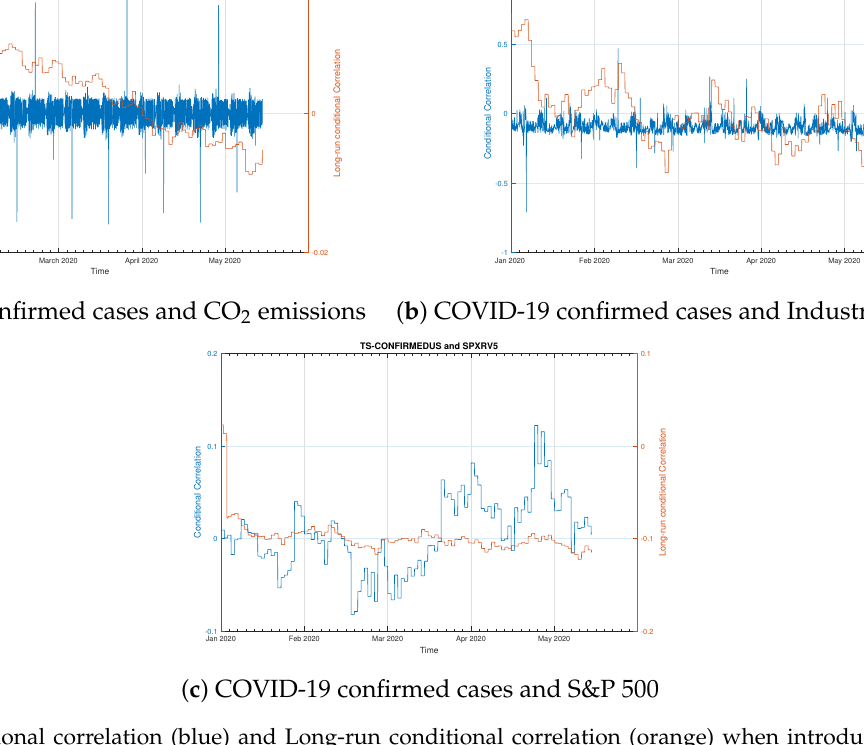
Figure 4. Conditional correlation (blue) and Long-run conditional correlation (orange) when introducing COVID-19 confirmed cases in the baseline